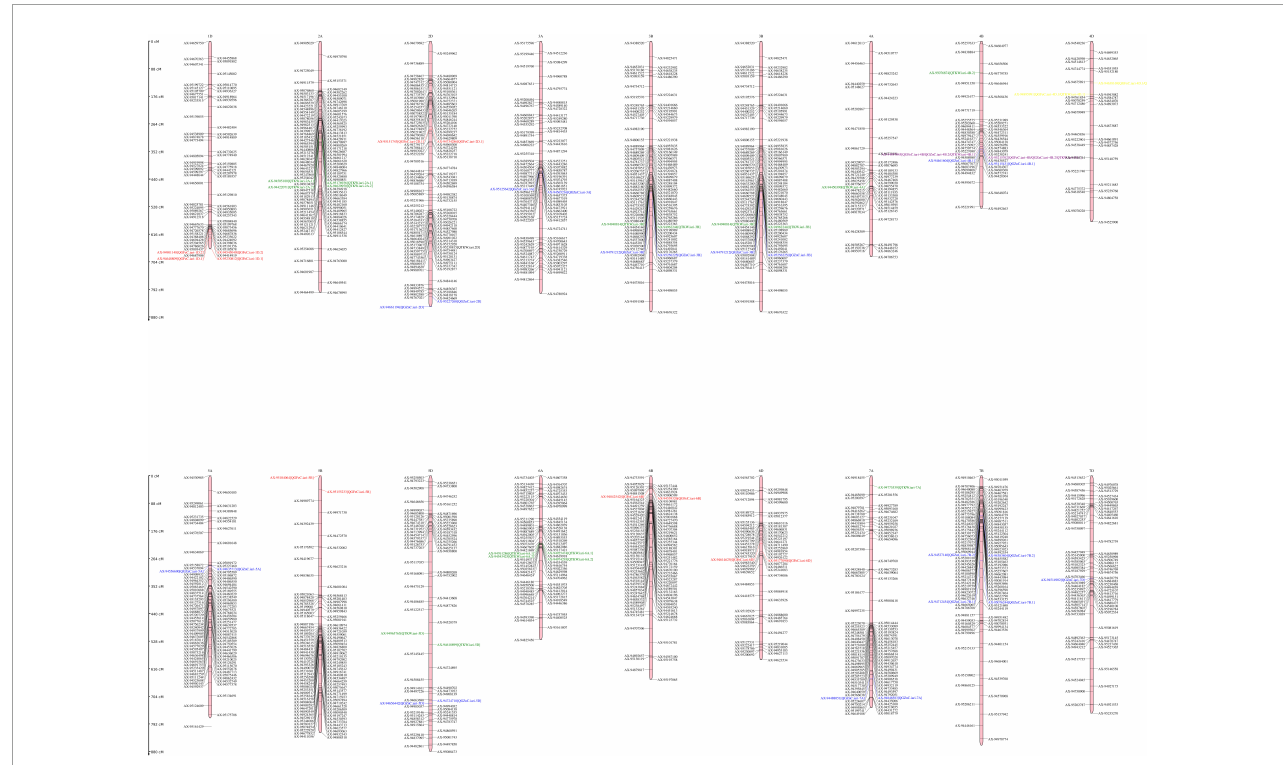
FIGURE2 Genetic linkage map and QTL positions identified on A, B, and D genomes of RILs derived from the cross HD3086/HI1500. Red color indicates QTLs for GFeC; blue color indicates QTLs for GZnC; green color indicates QTLs for TKW; purple color indicates QTL governing GFe, GZn and TKW; yellow color indicates QTL governing both GFe and